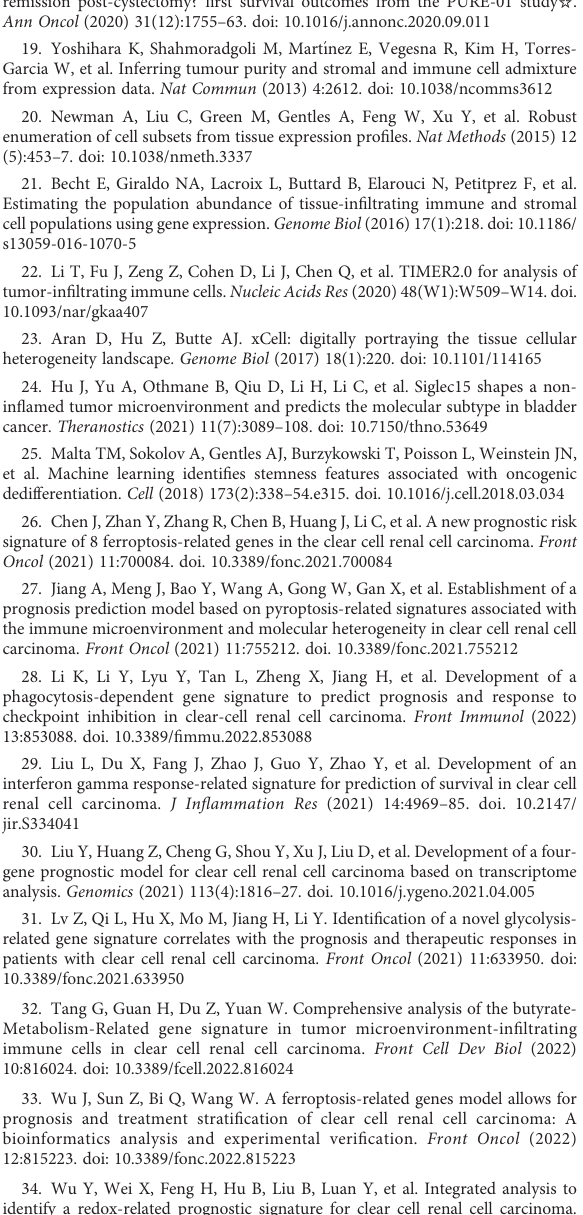
SUPPLEMENTARY FIGURE 2 Validation of the expression feature of claudin genes in other dataset and local ccRCC samples. (A) Silhouette clustering analysis in GSE40435, GSE53757, International Cancer Genome Consortium (ICGC) datasets, and local ccRCC samples; (B)